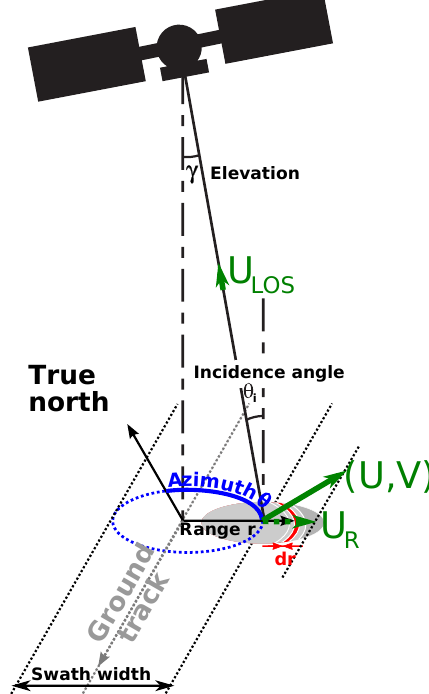
Figure 2. Geometry of measurement from a radar with a local in- cidence angle θ i , looking towards azimuth θ . For simplicity of the schematic, we have taken U WB = 0 and U NG = 0, so that the line- of-sight velocity is simply U LOS = (U sin θ + V cos θ) sin θ i . Note that the diameter of the footprint (6km) is exaggerated compared to the swath width (270km) for readability. The small difference between elevation γ and incidence angle θ i is due to the Earth cur-